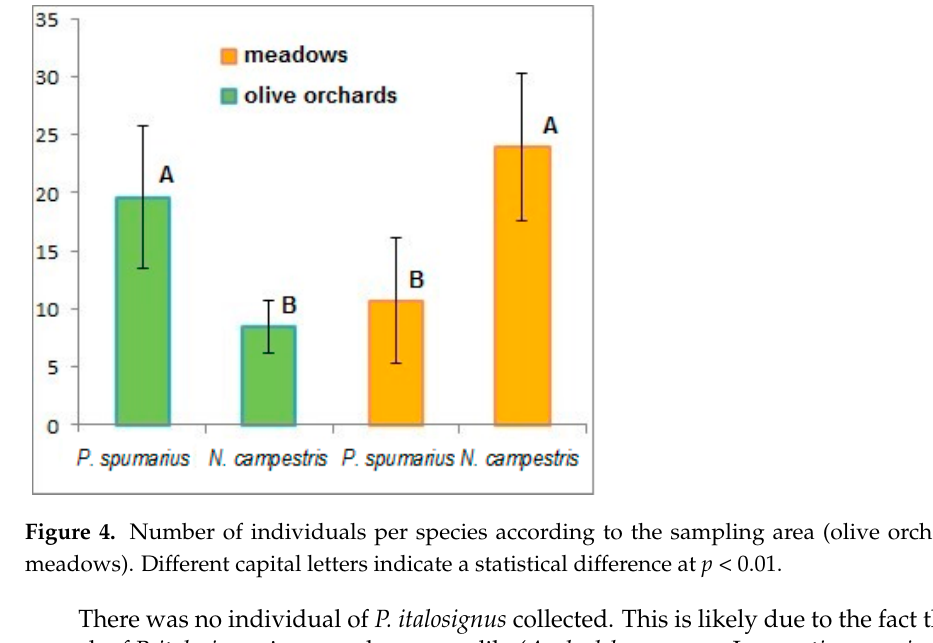
Figure 3. Abundance and distribution of P. spumarius and N. campestris throughout the sampling areas (municipalities).